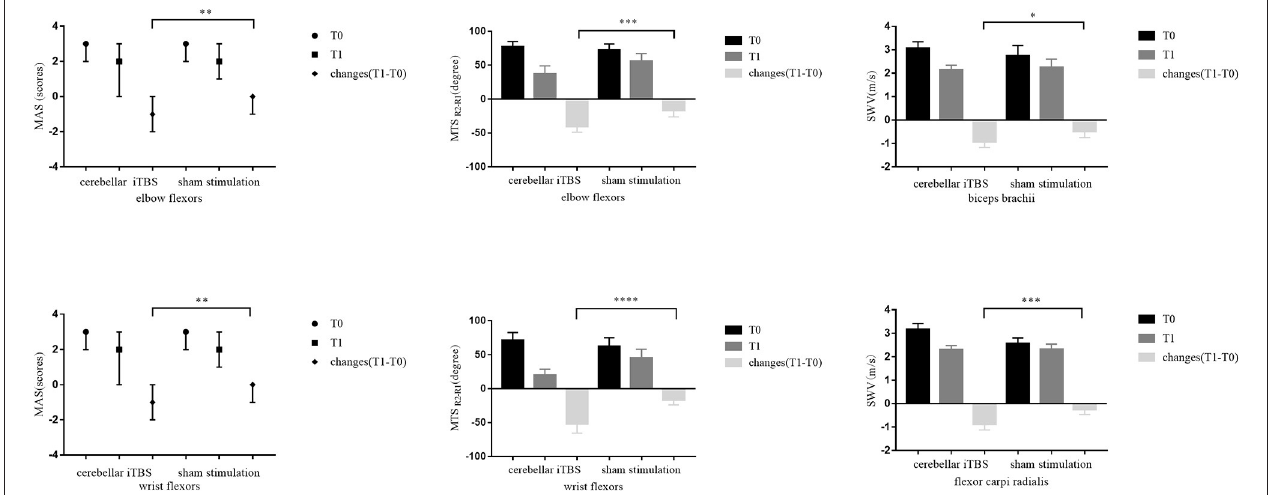
FIGURE 2 | The statistical analysis results between groups for the primary outcomes. The data are expressed as the Median with IQR or Mean with 95%CI. * P < 0.05, ** P < 0.01, *** P < 0.001, **** P <